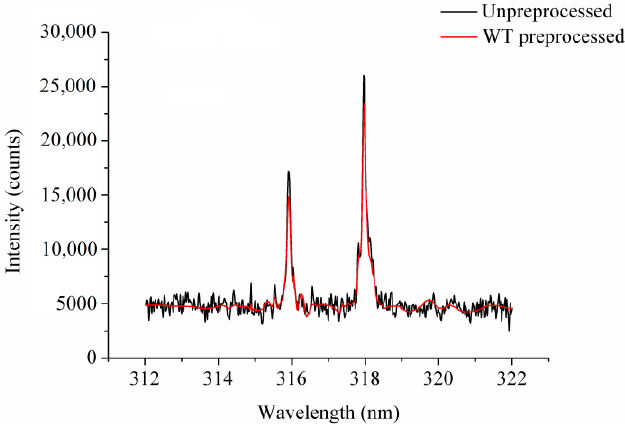
Figure 1. The un-preprocessed spectrum and the spectrum preprocessed by wavelet transform (WT).